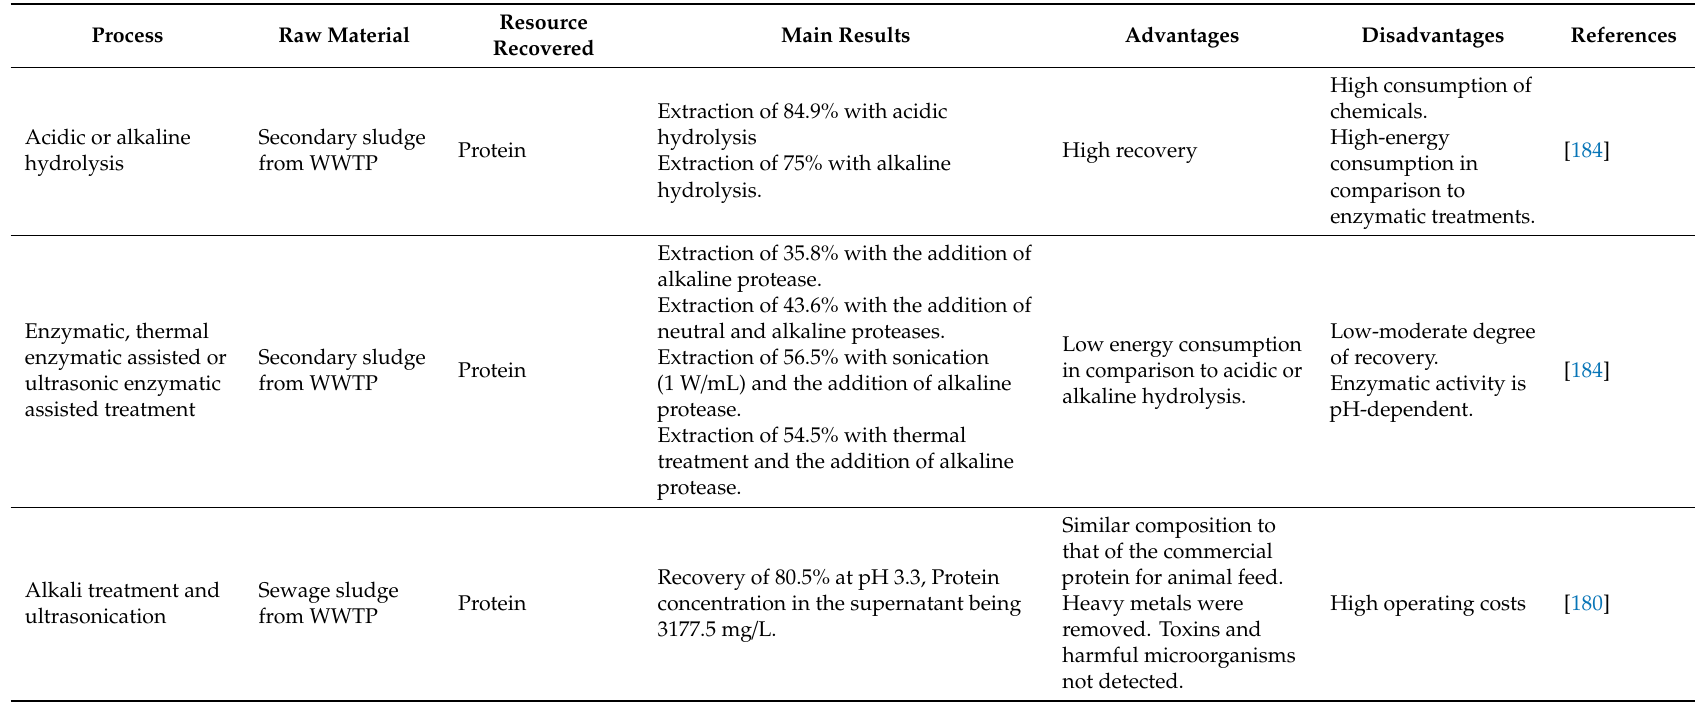
Table 9. Process employed for protein recovery from sewage